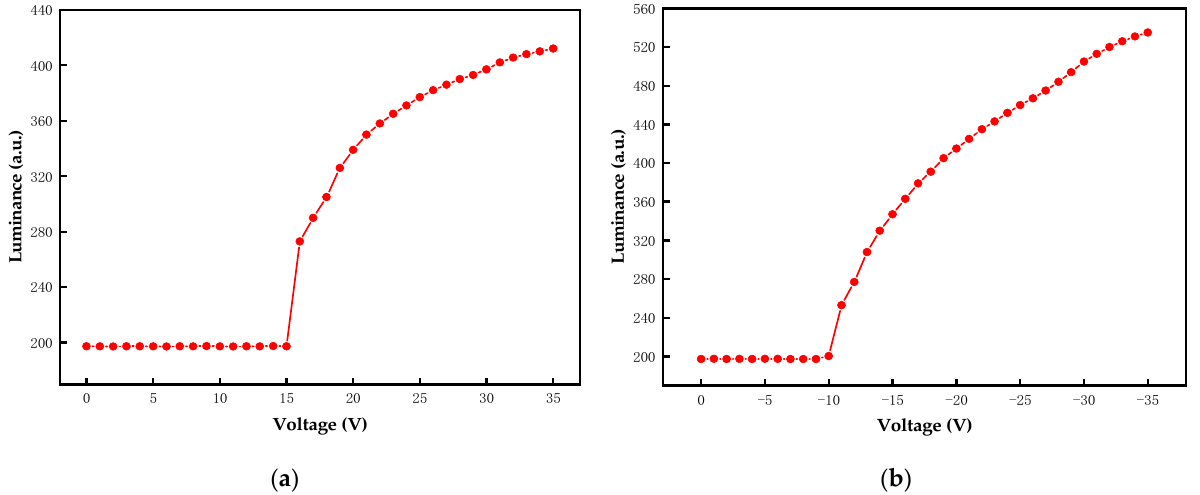
Figure 5. The relationship curves of luminance values and different DC voltages. ( a ) The EWD was driven by a positive DC voltage, and its range was 0 V to 35 V. ( b ) The EWD was driven by a negative DC voltage, and its range was 0 V to − 35 V.